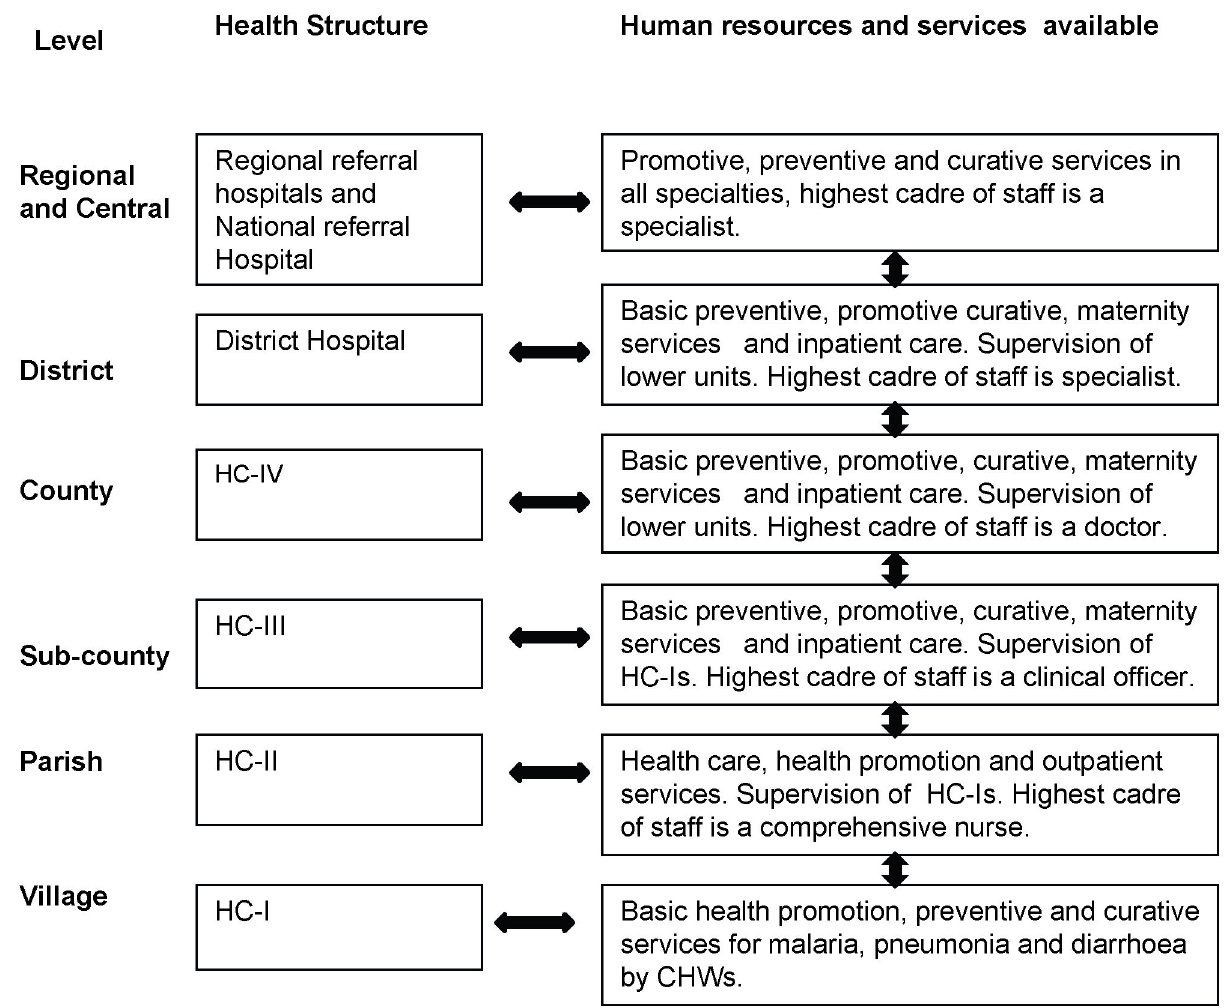
Figure 1. A diagrammatic depiction of the health system hierarchy in